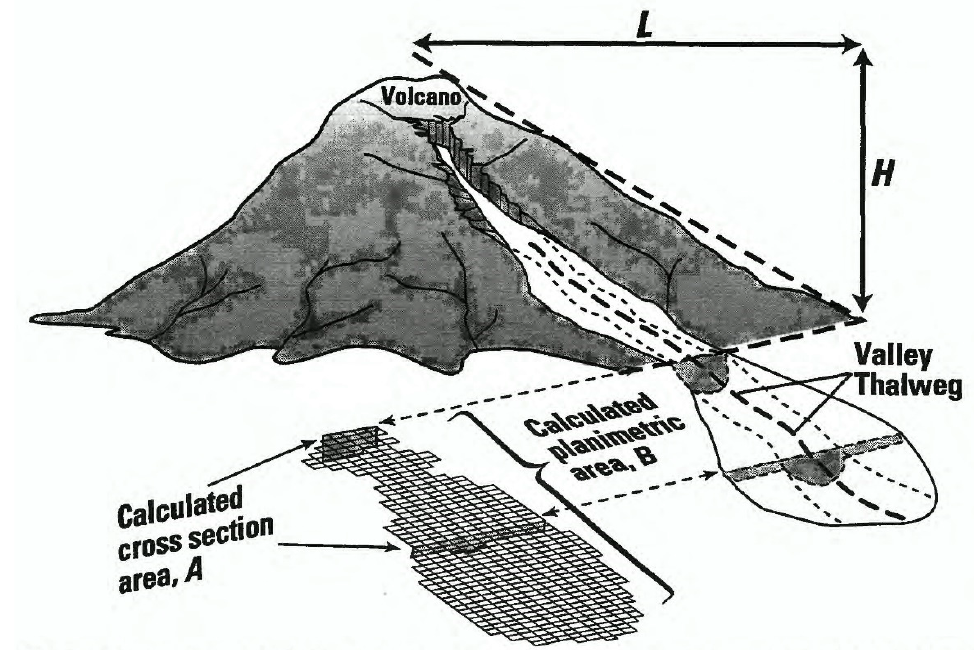
Figure 2. Diagram of association between dimensions of an idealized lahar and cross-sectional (A) and planimetric (B) areas calculated by LAHAR Z for a hypothetical volcano. The ratio of vertical drop (H) to horizontal runout distance (L) describes the extent of proximal volcano hazard. LAHAR Z begins calculations of lahar-inundation hazard zones where a user-specified stream and the proximal-hazard zone boundary intersect [6].